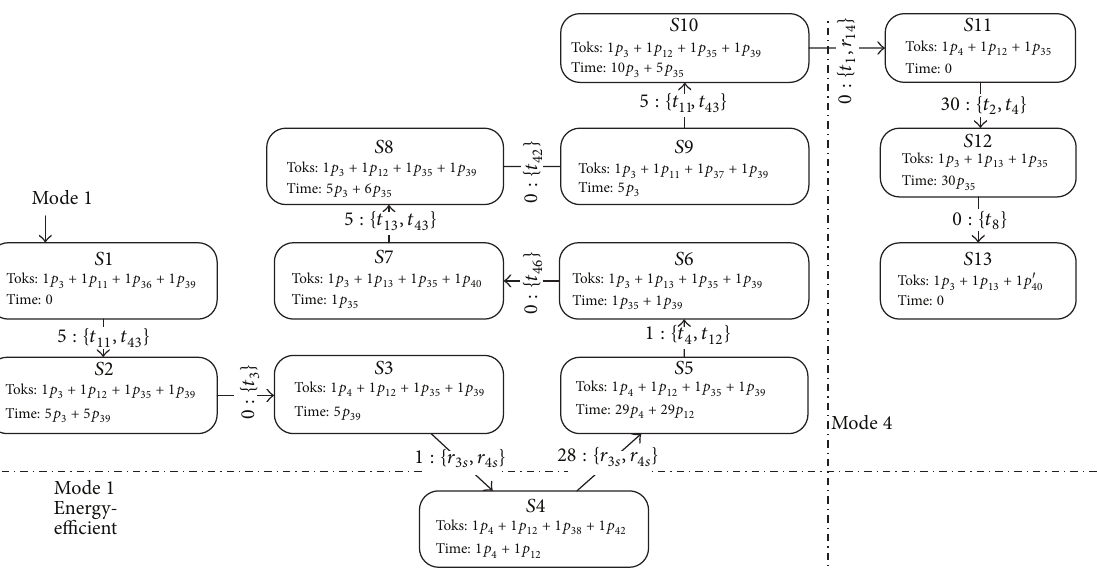
Figure 7: A fragment of the reachability graph of Example 7.